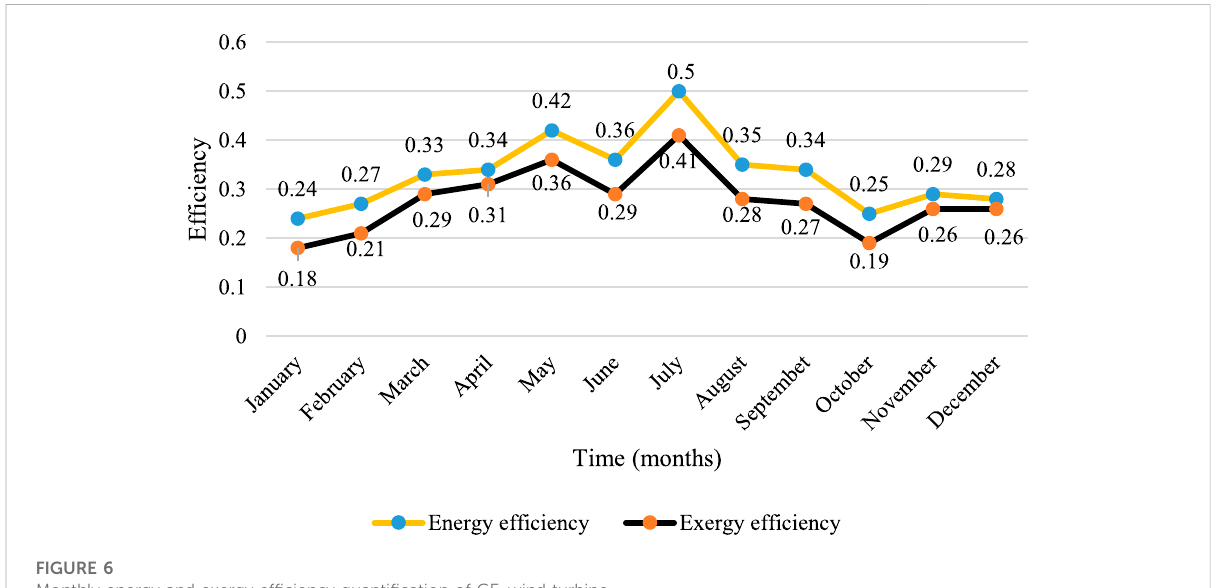
FIGURE 6 Monthly energy and exergy ef fi ciency quanti fi cation of GE-wind